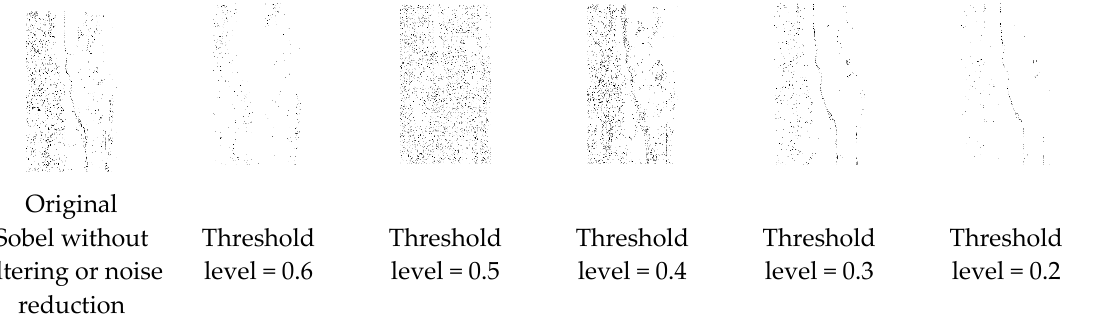
Figure 8. Obtained images were inverted to view the visible crack region of sample images easily.